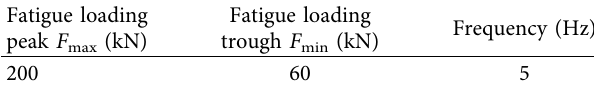
Table 4: Fatigue loading test scheme. Fatigue loading